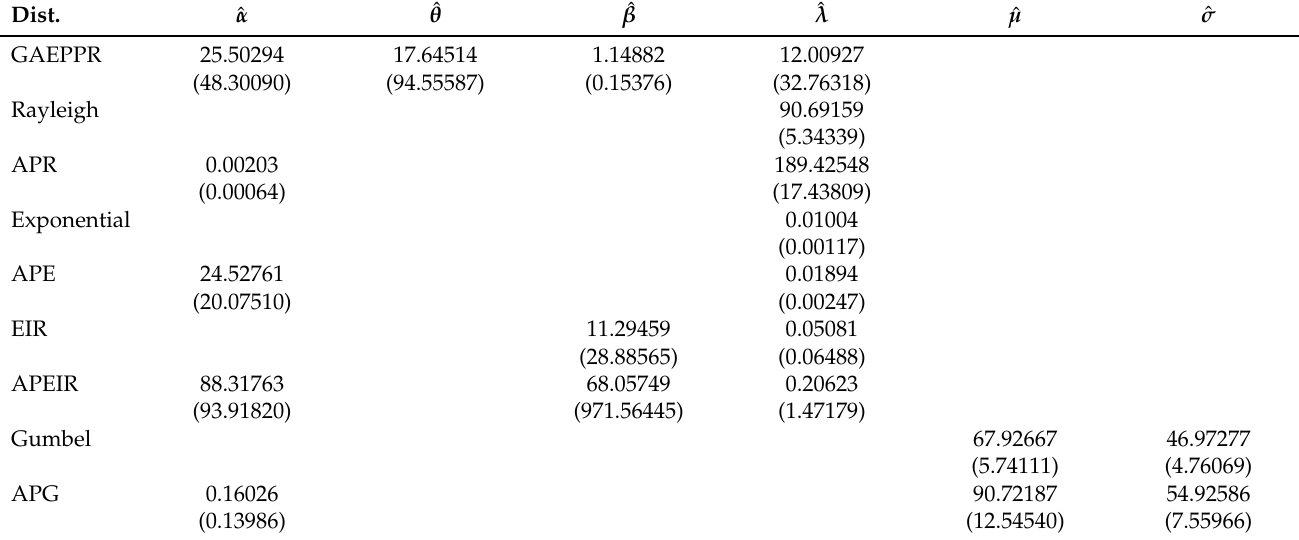
Table 2. MLEs with SE (in parentheses) of competing models for strength glass fiber data.